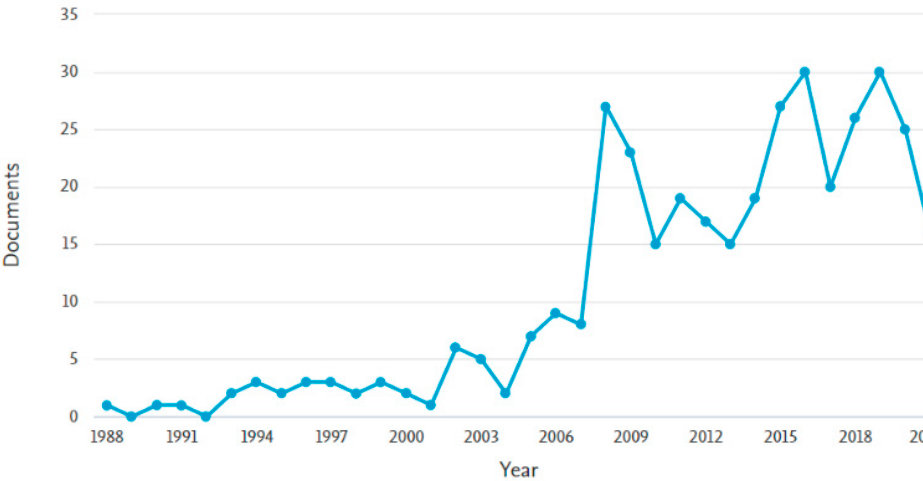
Figure 1. Documents by year of publication.